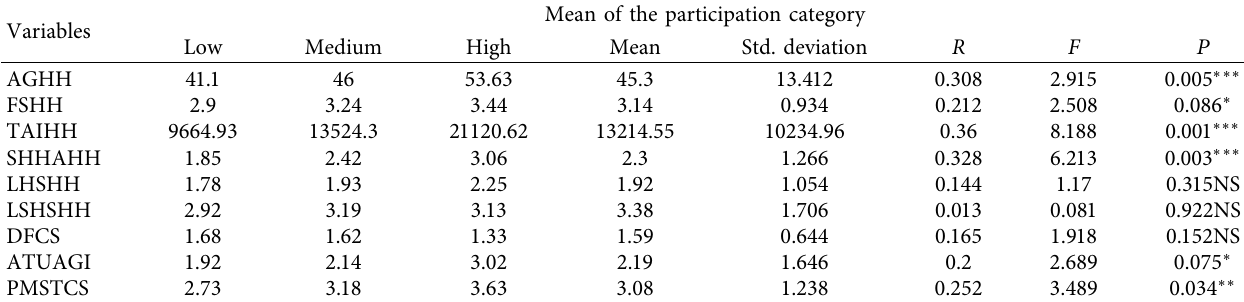
Table 12: Summary of continuous variables and relationship between member participation.